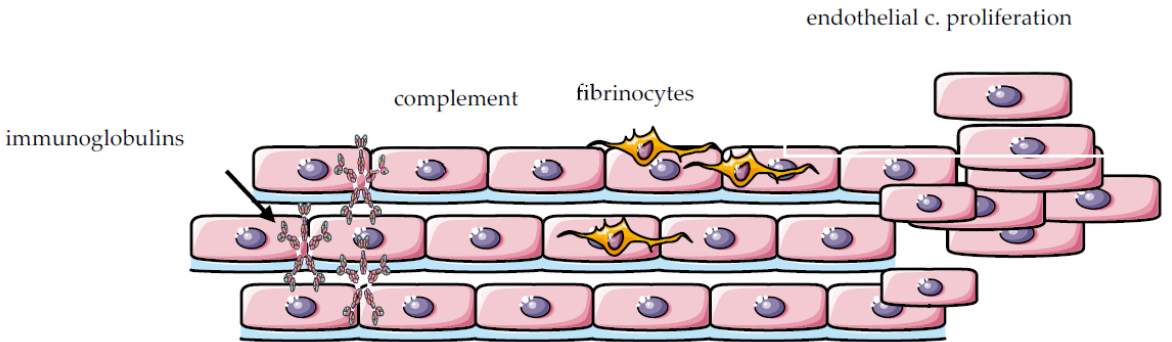
Figure 2. Schematic pulmonary vessel wall and magnification of histopathological features included endothelial and smooth muscle cell proliferation, fibrinoid vasculitis and deposition of immunoglobulins and complement components in the intimal and medial layers of the pulmonary vessels in patients with SLE-related PAH.